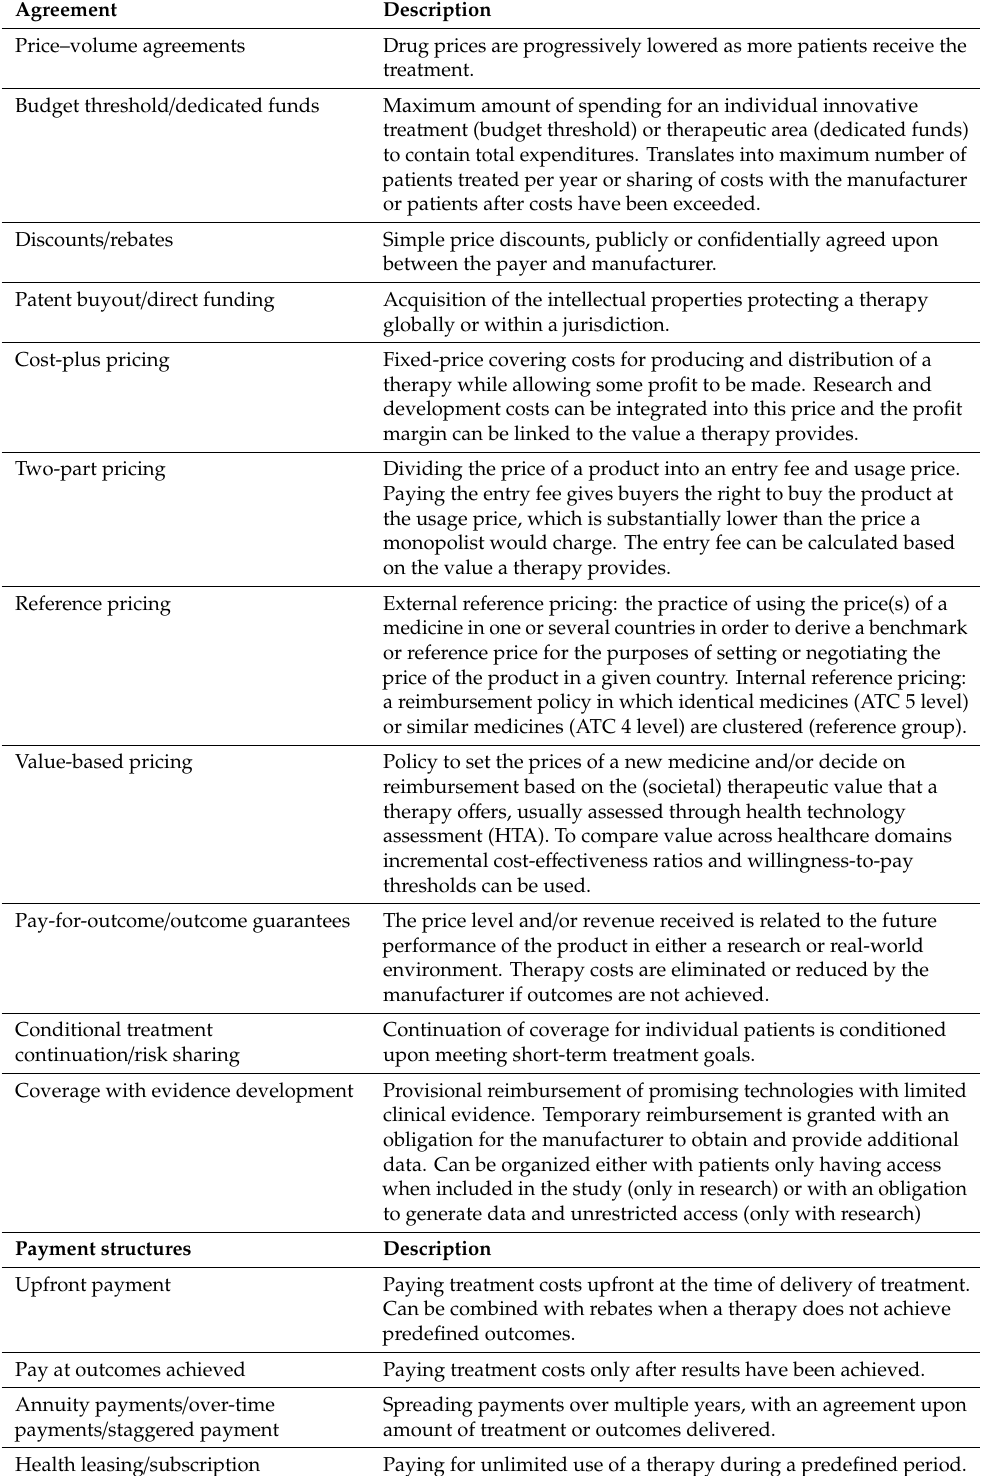
Table 1. Overview and description of identified managed entry